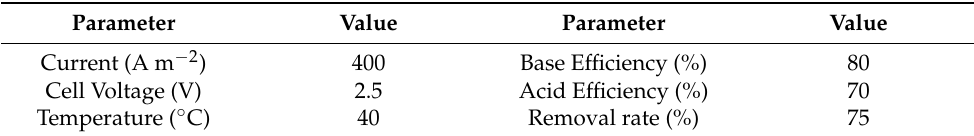
Table 3. Operating condition.